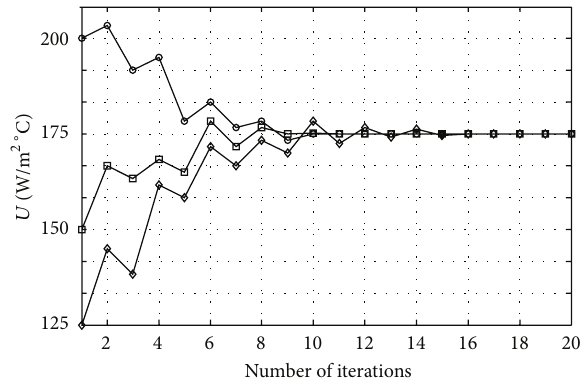
Figure 3: Convergence curve for different initial guesses of 𝑈 .